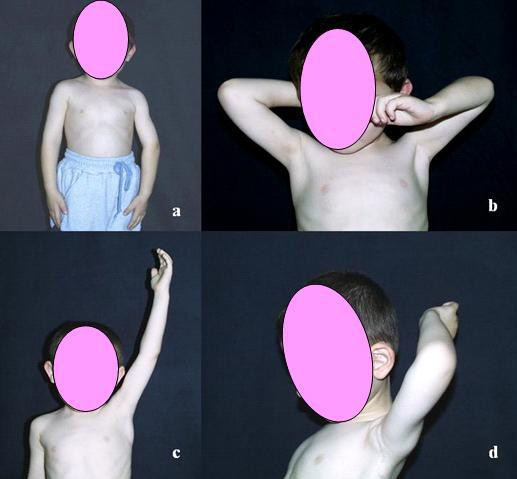
An example case from Group II, Case 38 in Table 1: 5 years old boy with left brachial plexus palsy. (a), (b) Anterior views of the patient while performing abduction of his both arms. Preoperative abduction degree is 110° and external rotation degree is 24°. (c) Anterior postoperative view of the patient while performing abduction. (d) Lateral postoperative view of the patient while placing his hand at the nape of his neck. Postoperative abduction degree is 170° and external rotation degree is 90°.